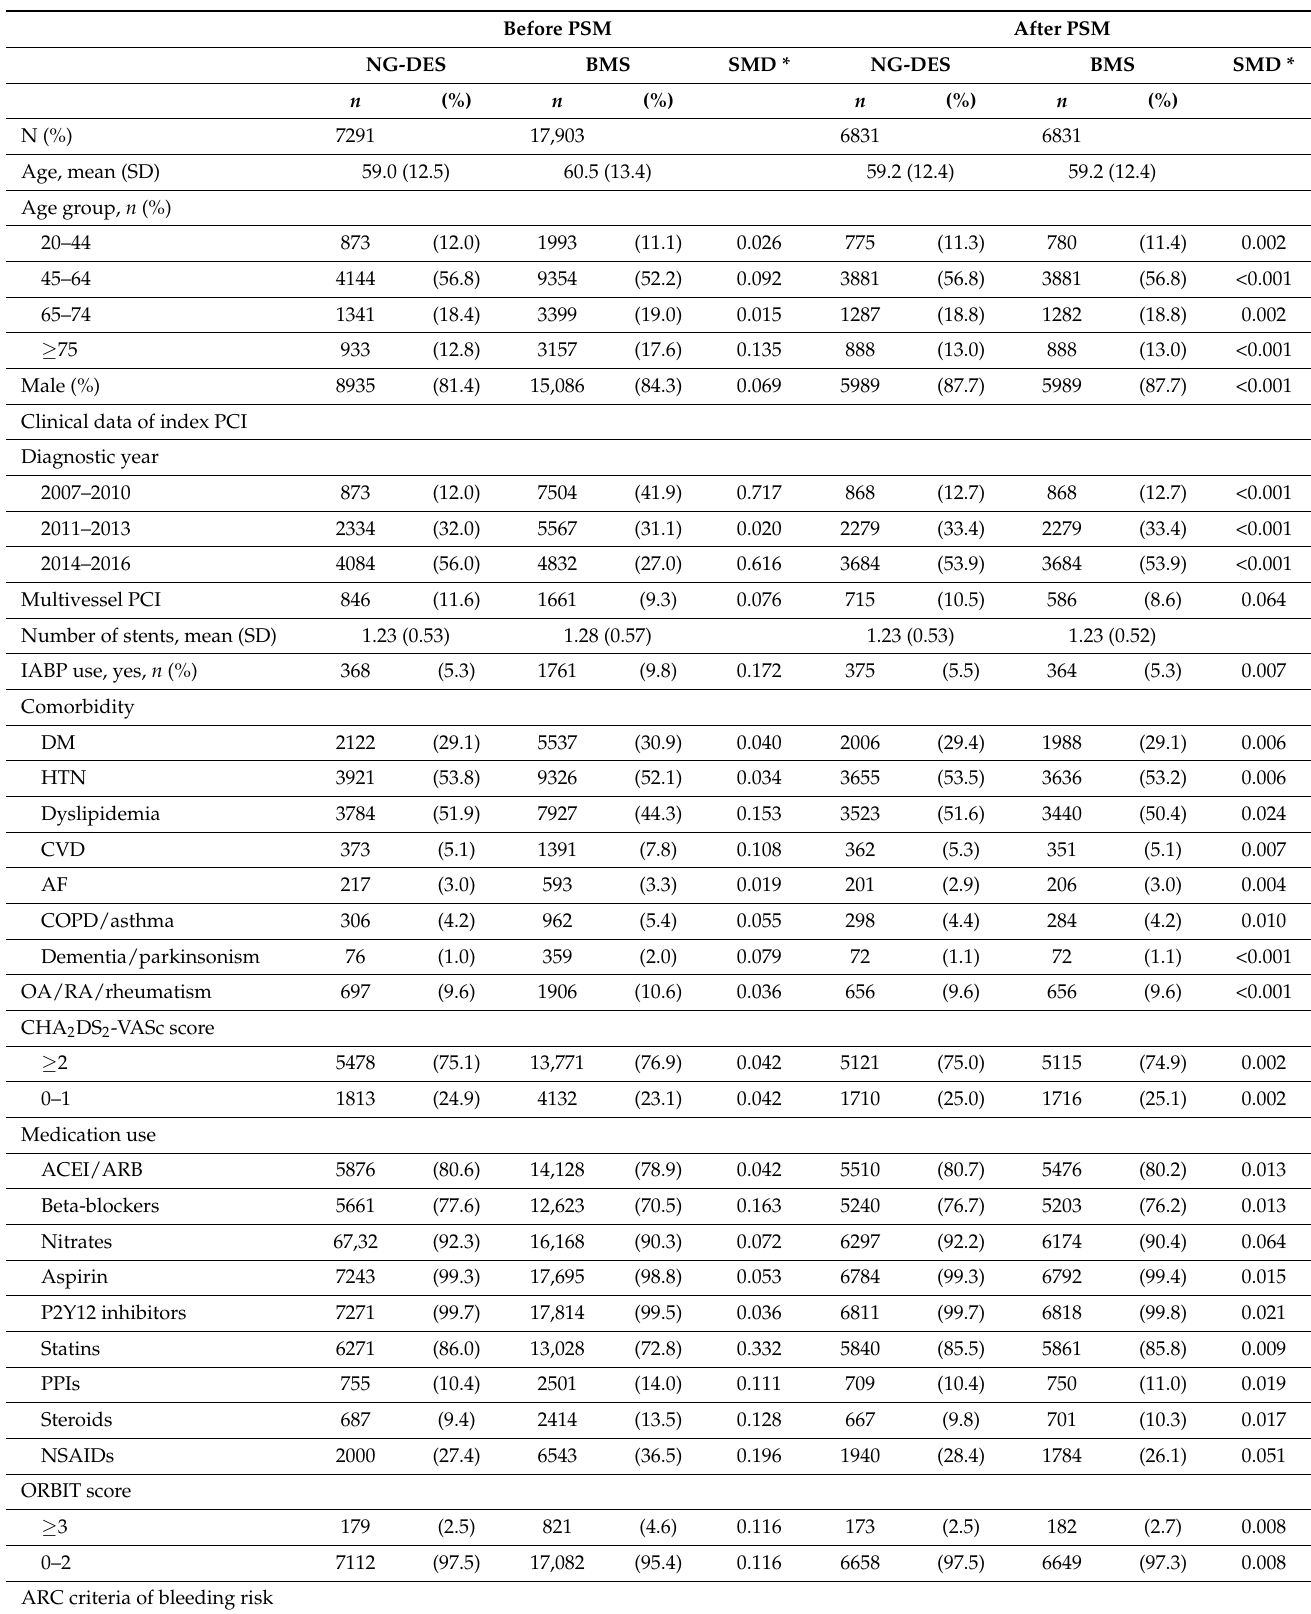
Table 1. Baseline characteristics of patients with STEMI receiving NG-DES or BMS before and after